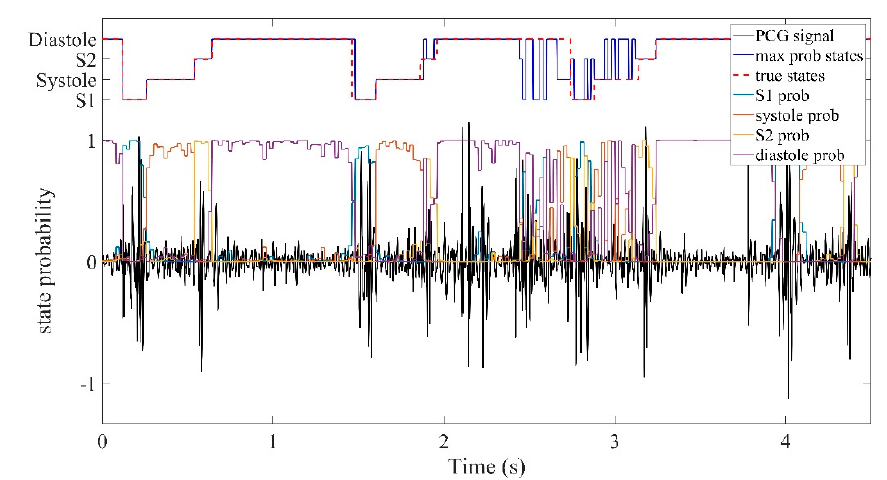
Figure 2. Example of direct classification annotation based on the feature classification results for a noisy heart sound. The feature classification result output from the temporal convolutional network (TCN) comprises the state probabilities for each time point, and the direct classification annotation is the max probability state at each time point.